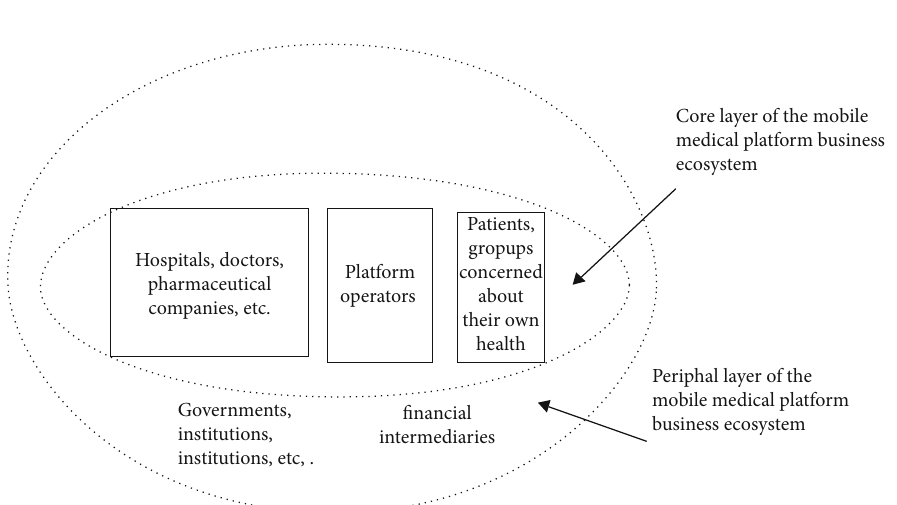
Figure 2: Business ecosystem model of mobile medical platform.